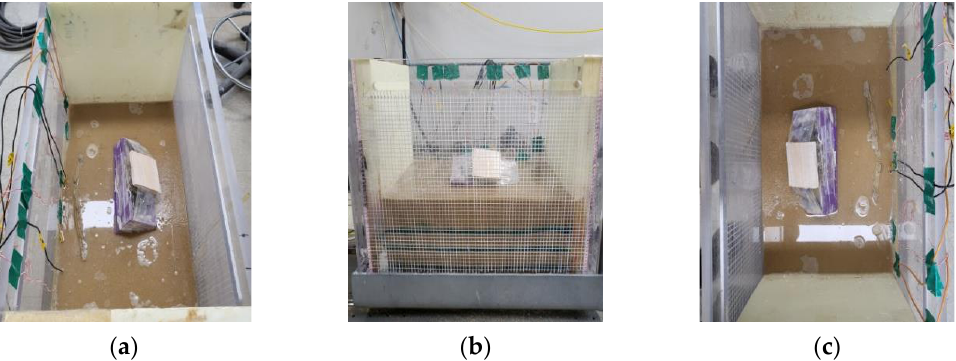
Figure 9. Grouting mixing ratio of 0.40 and separation distance of 1 cm: ( a ) Settlement ( b ) Pore Water Pressure Ratio.